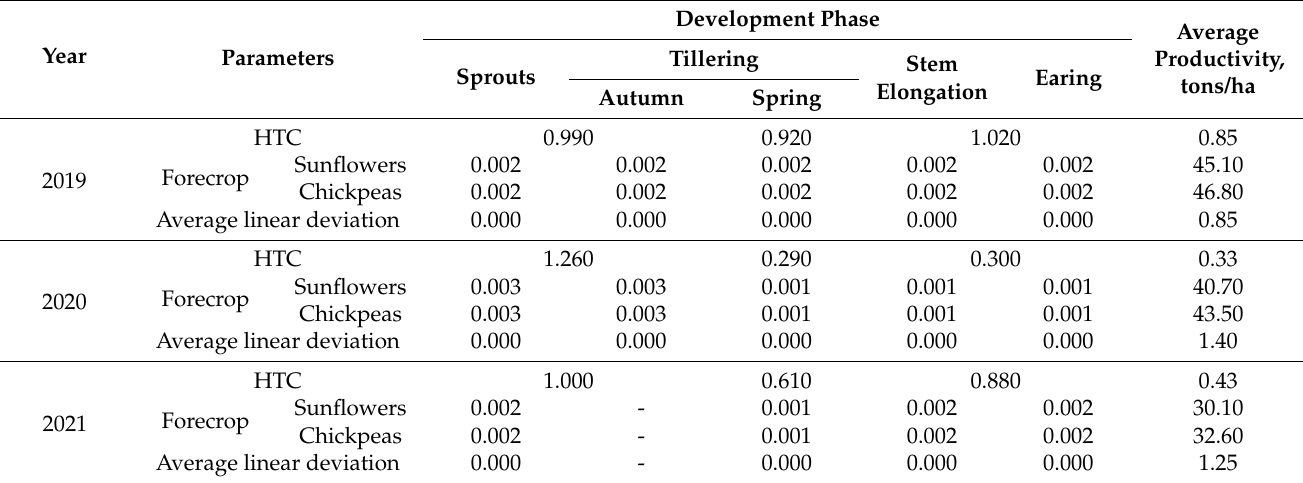
Table 9. Effect of HTC on winter wheat plant density index (PD), units/m 2 .